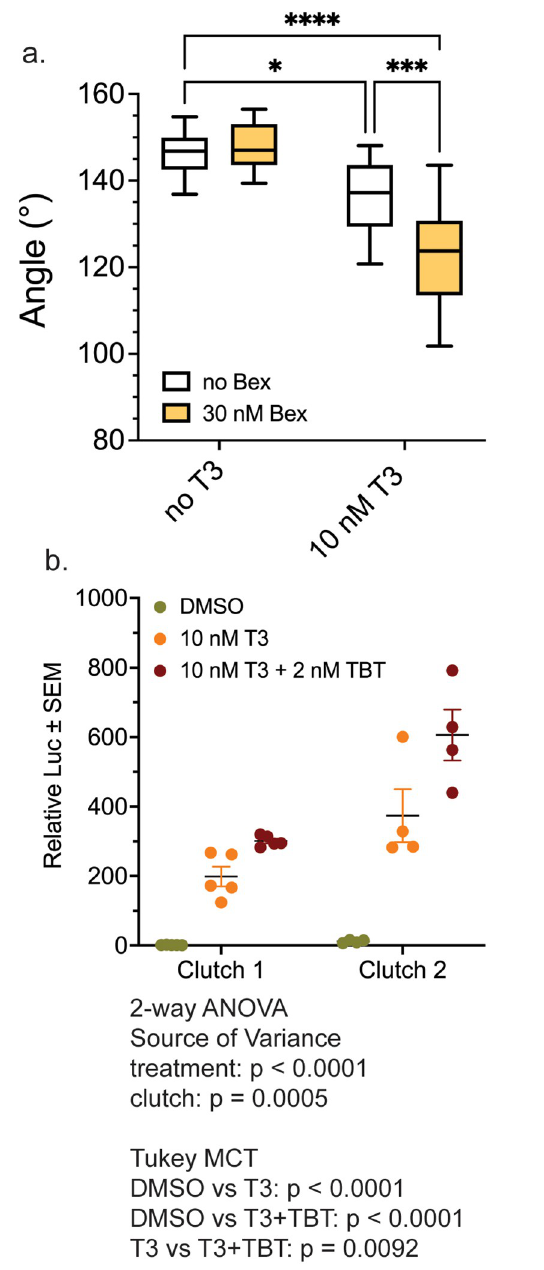
Fig 5. RXR agonists potentiate T3 action in the LJ in pro-metamorphic NF 54 tadpoles. a. Bex potentiates the T3-induced decrease in the LJ angle in NF 54 tadpoles treated for three days. Boxes and statistics are as in Fig 1 (n = 14 jaws from 3 clutches). Statistics show results from Sidak’s multiple comparison test in conjunction with 2-way ANOVA ( ���� , p < 0.0001; ��� , p < 0.001; � , p < 0.05). b. TBT potentiates T3-inducible, integrated luciferase reporter expression in the LJ of NF 54